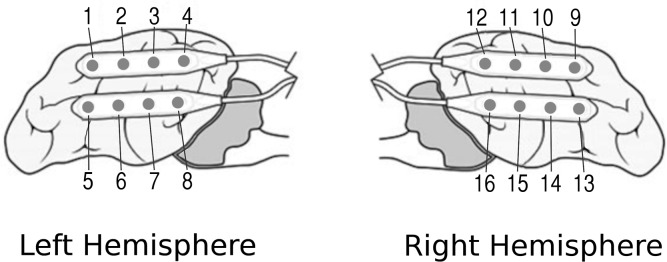
Approximate placement and numbering of sixteen implanted electrode contacts relative to the canine cortical anatomy.